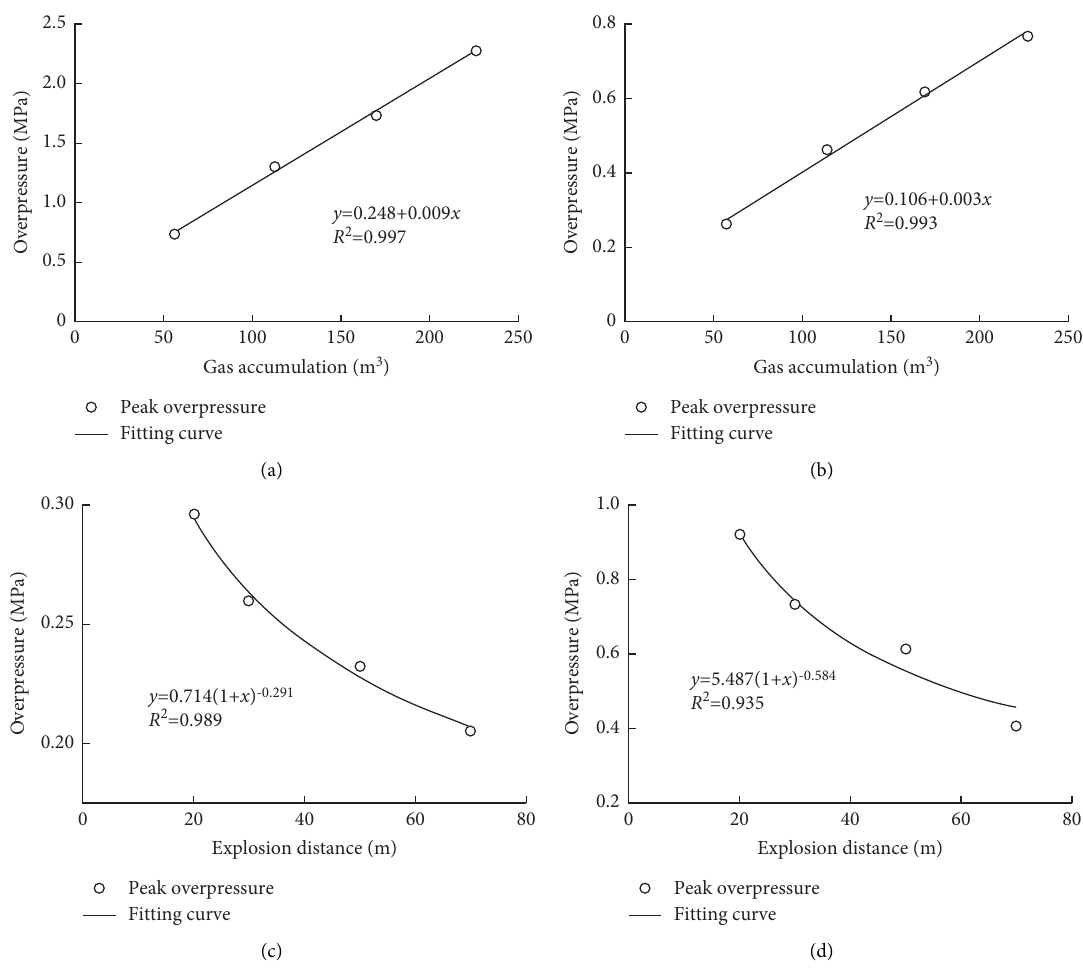
Figure 1: Fitting of influence law of overpressure peak value [23]. (a) Effect of gas accumulation on the peak overpressure at the explosion door. (b) Effect of gas accumulation on the peak overpressure at the fan. (c) Explosion distance on the peak overpressure at the fan. (d) Explosion distance on the peak overpressure at the explosion